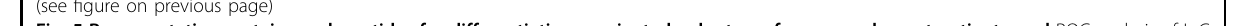
Fig. 5 Representative proteins and peptides for differentiating vaccinated volunteers from convalescent patients. a – d ROC analysis of IgG responses to the S protein (black), S1 subunit (red), and RBD (orange) for comparing vaccinated volunteers and convalescent patients ( a ), the N protein (black), N-Nter (red), and N-Cter (orange) ( b ), NSP7 ( c ), and two combinations, i.e., N-Nter and NSP7 (black) and the N protein and NSP7 (red) ( d ). e , f Scatter plots of IgG responses of vaccinated volunteers (red dots) and convalescent patients (black dots) for N-Nter vs NSP7 ( e ) and the N protein ( f ) vs NSP7. g – i ROC analysis of IgG responses to S1-5 (black), S1-24 (red), and S1-113 (orange) for comparing vaccinated volunteers and convalescent patients ( g ), S2-16 (black), S2-22 (gray), S2-41 (green), S2-78 (red), and S2-94 (orange) ( h ), and the combination of S1-24 and S2-78 ( i ). j Scatter plots of IgG responses of vaccinated volunteers (red dots) and convalescent patients (black dots) for S1-24 vs S2-78. The gray lines in ( e ), ( f ), and ( j ) indicate cutoff values based on optimal Youden indices of related ROC curves. Unless otherwise stated, sera collected after the 2nd dose were